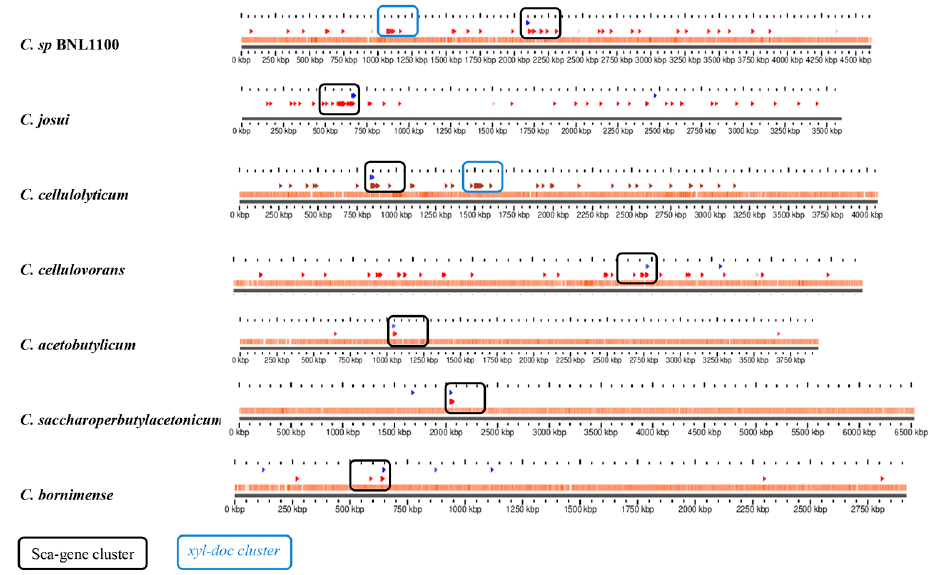
Figure 6. Arrangement of cohesins and dockerins along the bacterial chromosomes of cellulosome-producing mesophiles. Cohesins (blue triangles) and dockerin modules (red triangles) were searched by BLAST and located on the bacterial chromosome. Known clusters of dockerins (the xyl-doc cluster) and the sca gene cluster are marked in blue and black rectangles, respectively, whereas most other dockerin-containing genes were distributed along the chromosome.